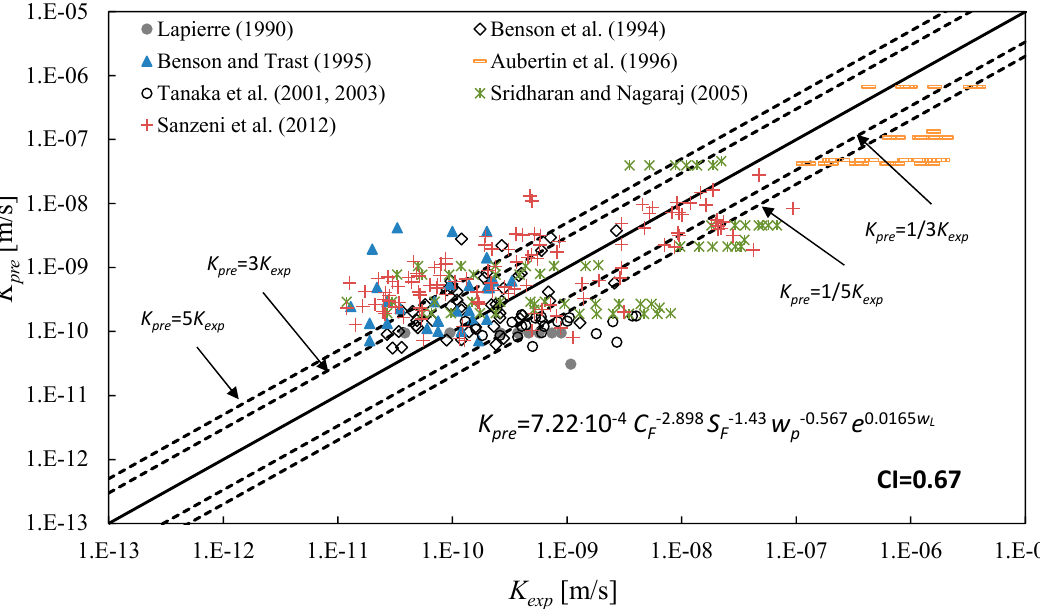
Figure 4. Experimental ( K exp ) and predicted value ( K pre ) of the saturated hydraulic conductivity as determined by Equation (21).